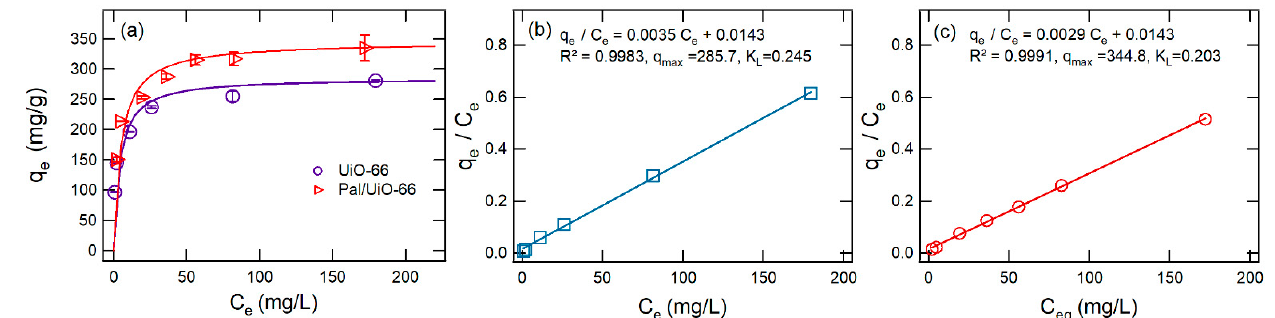
Figure 6. Adsorption isotherms using different MO initial concentration on the pure UiO-66 and composite material ( a ). Isotherms based on the Langmuir model for pure UiO-66 ( b ) and Pal/UiO-66 ( c ) and the corresponding isotherms parameters. Experimental conditions: initial MO concentration 40–300 mg L − 1 , 0.4 g L − 1 of the adsorbent, pH = 5, volume 50 mL, and T = 25 ◦